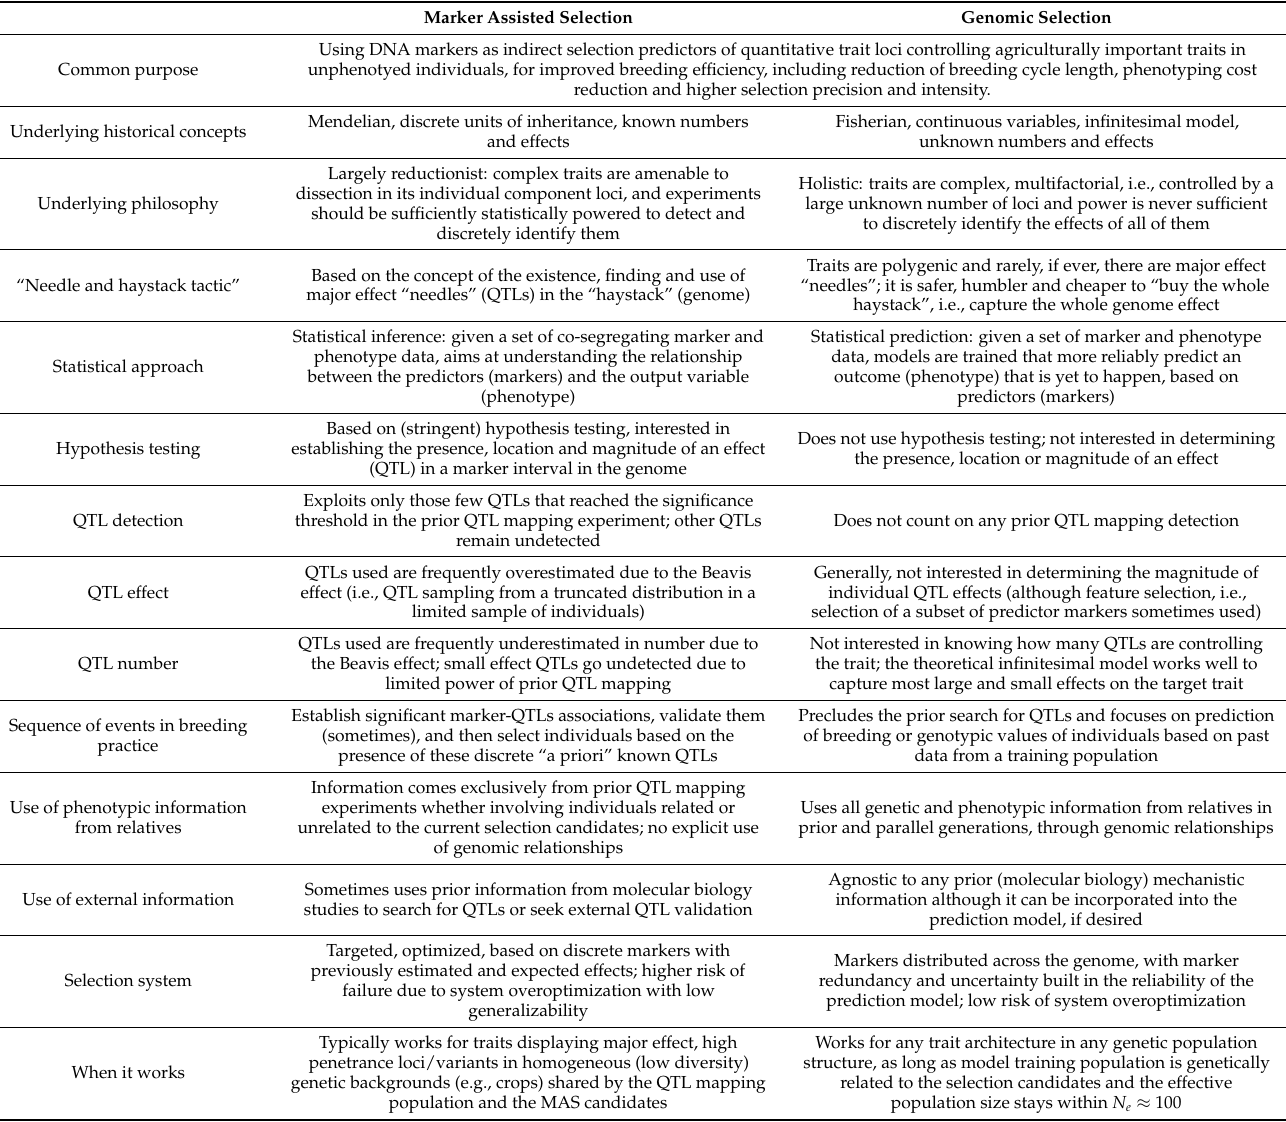
Table 1. Comparative summary of the underlying concepts, philosophy, premises and practice of Marker Assisted Selection versus Genomic